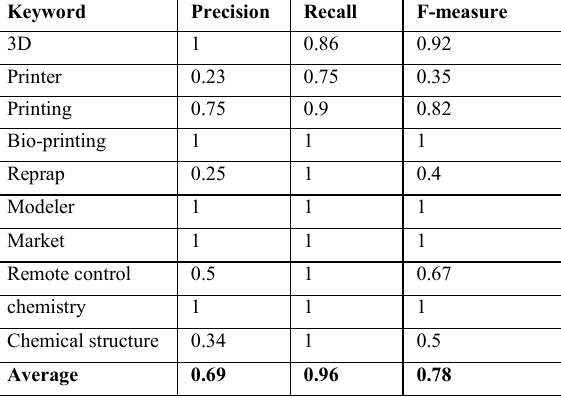
Table 4. The performance on each keyword in 3D printing